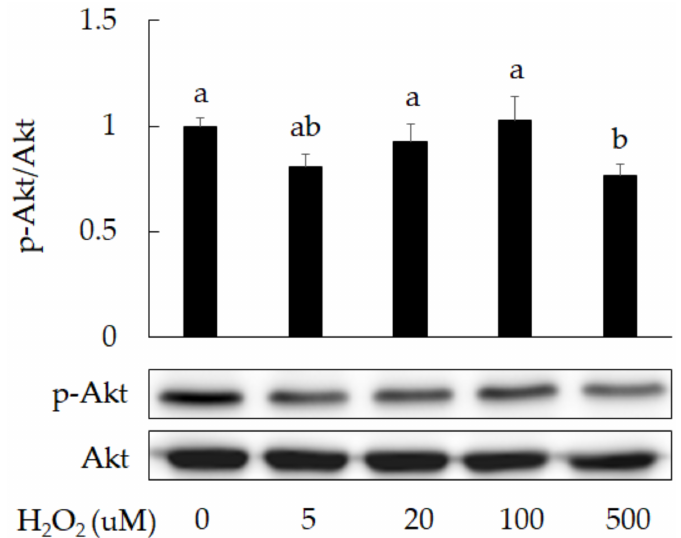
Figure 2. The reduction of Akt phosphorylation in 3A-sub-E placental cells treated with H 2 O 2 for 24 h. Data were shown as mean ± SD (n = 3). Significant difference ( p < 0.05) were indicated by different letters (a, ab, b) .